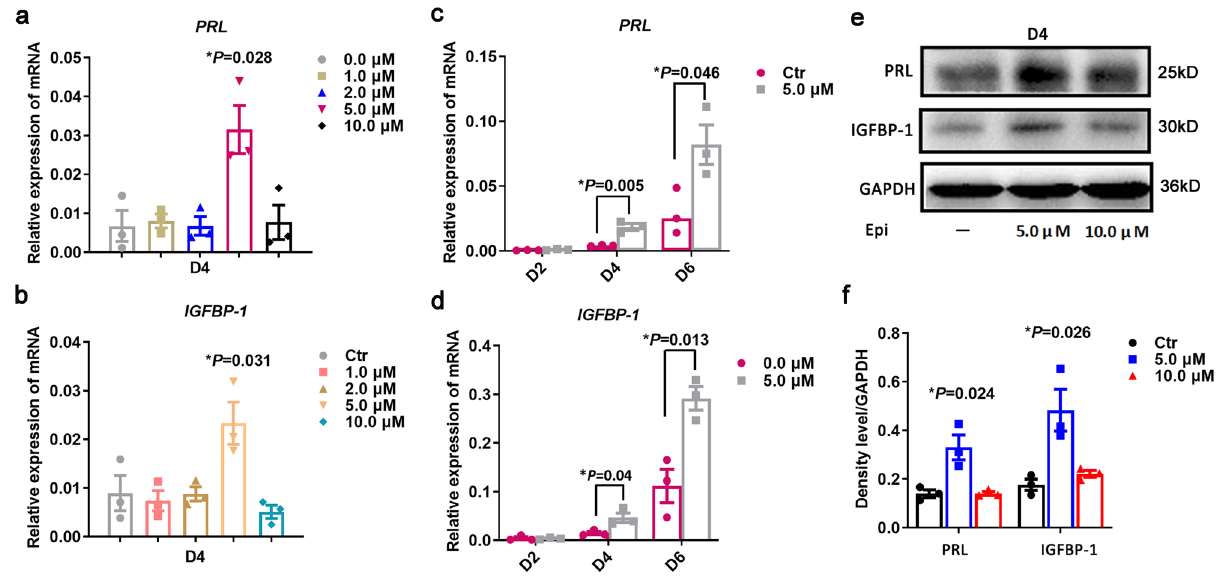
Fig. 3 Dose-dependent role of adrenergic signaling in HESCs during decidualization. a , b The mRNA levels of decidualization markers prolactin ( PRL ) and insulin-like growth factor-binding protein 1 ( IGFBP-1 ) on the 4th day of decidualization in the control and epinephrine-treated group. The values were normalized to the GAPDH expression level and indicated as the mean ± SEM, n = 3. c , d The mRNA levels of decidualization markers PRL and IGFBP-1 in control and 5.0 μ M epinephrine treated HESCs during induced decidualization at different time. The values were normalized to the GAPDH expression level and indicated as the mean ± SEM, n = 3. e Western blot for PRL and IGFBP-1 protein expression level, with GAPDH as a loading control. f Relative fold change in density levels for e